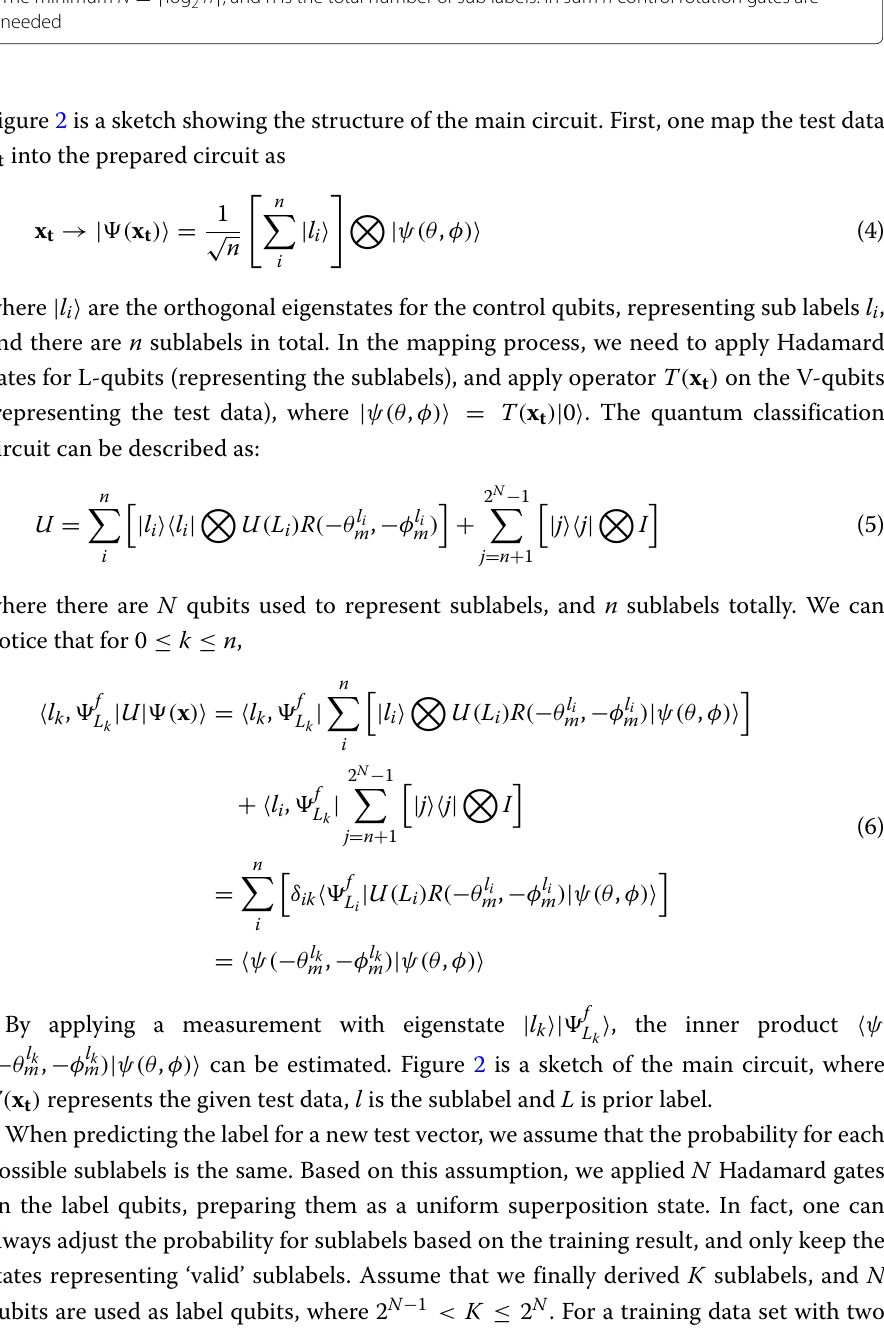
Fig. 2 Sketch of the main circuit: Qubits in the main circuit can be divided into two groups: L-qubits to represent the sub labels, and will play the role of control bits and the V-qubits to represent a given vector. ) ⊗ N , where there are N qubits representing the sub labels. Initially, L-qubits will be prepared at state ( | 0 (cid:2)+| 1 (cid:2)√ 2 The minimum N = (cid:6) log 2 n (cid:7) , and n is the total number of sub labels. In sum n control rotation gates